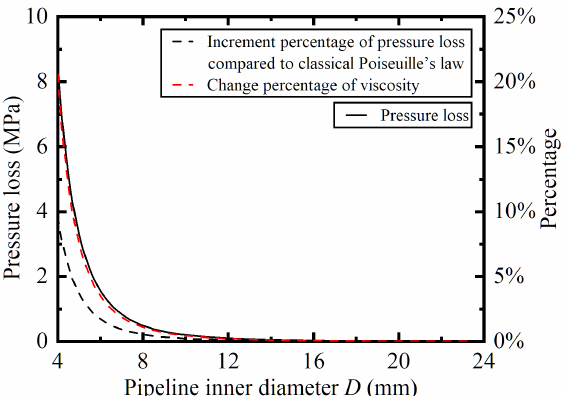
Figure 13. Pressure loss versus pipeline inner